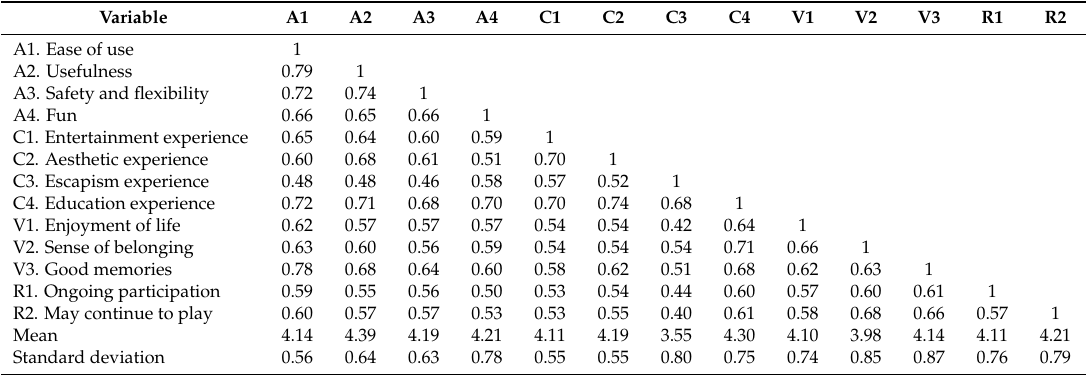
Table 2. Correlations between variables.